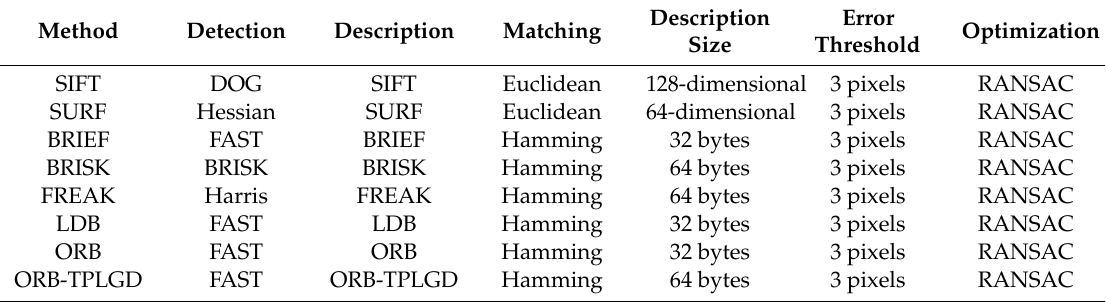
Table 2. Test parameters, test methods, and parameter settings used in the